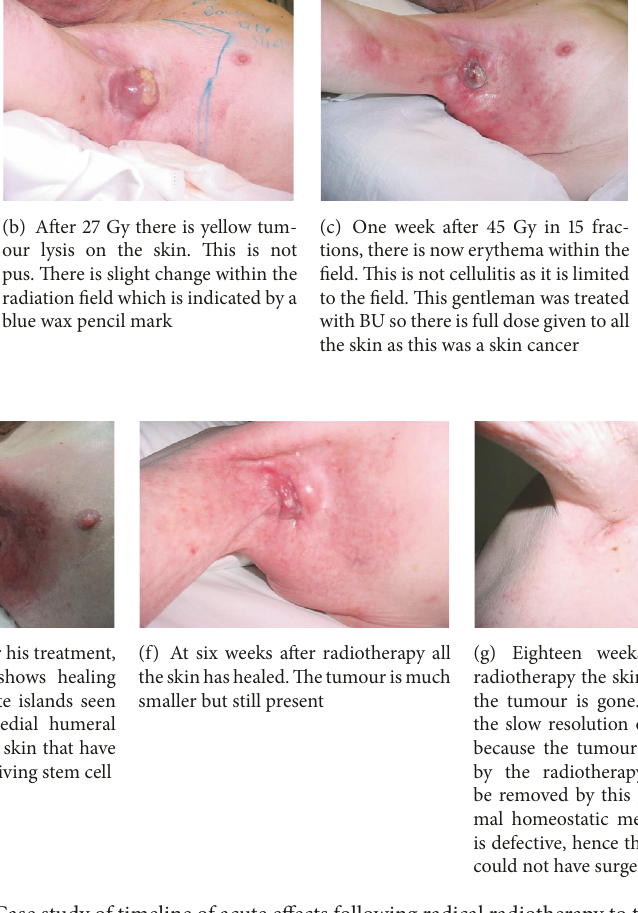
Figure 11: Case study of timeline of acute effects following radical radiotherapy to the